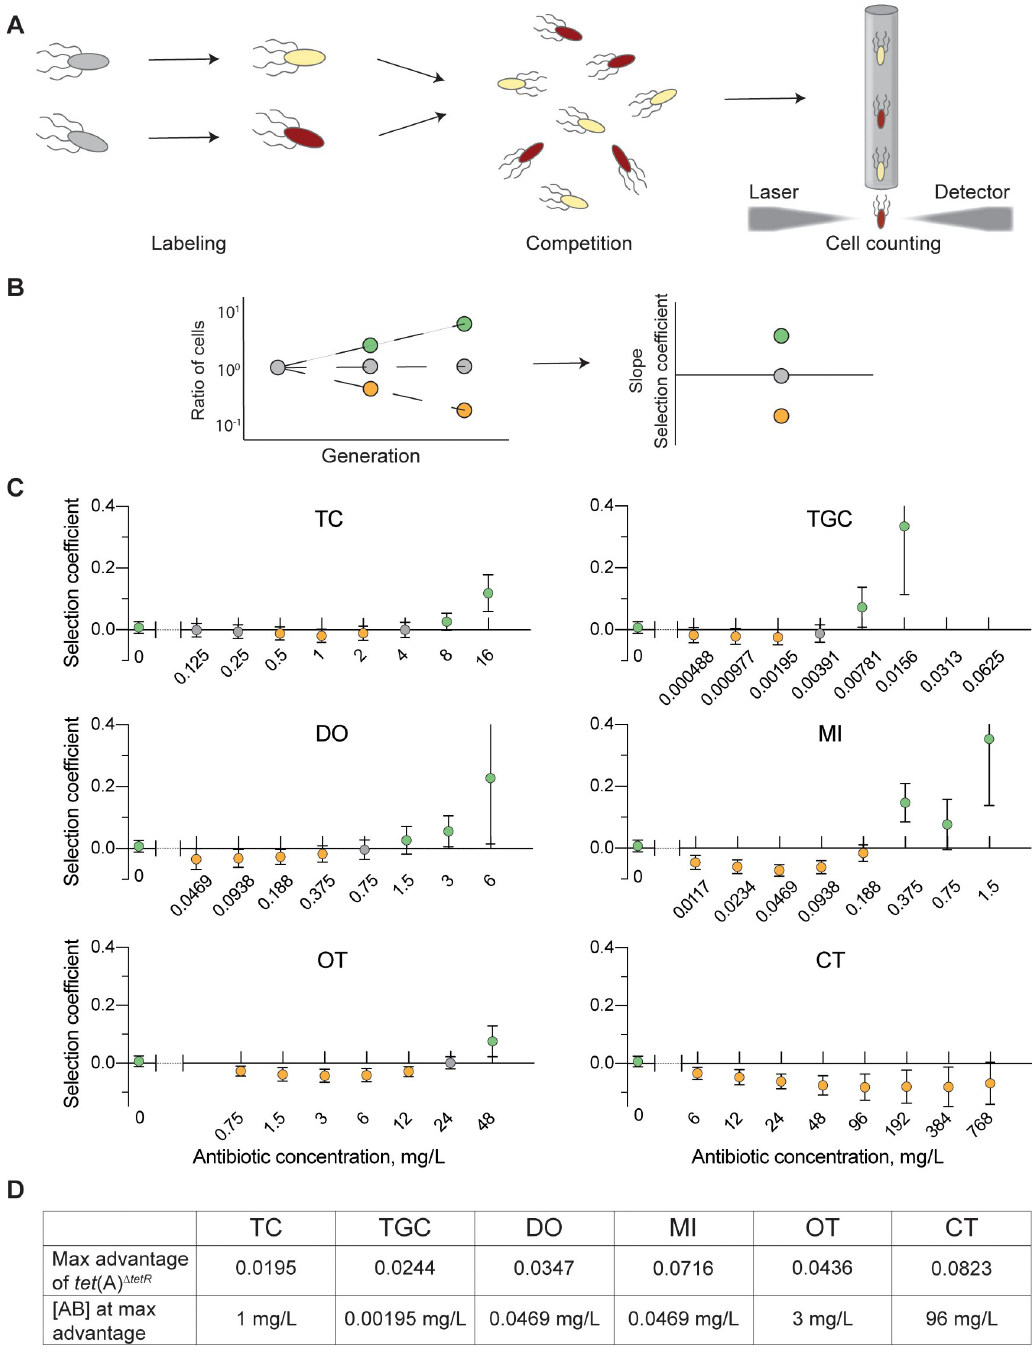
Fig 5. Competition analysis of strains carrying different tet (A) alleles in presence of increasing antibiotic concentrations. ( A ) Schematic of head-to-head competition experiments. Isolates to be competed are labelled with fluorescent markers and mixed at equal proportions. After competition growth, cells are counted using a flow cytometer to determine the cell ratio. ( B ) Example of ratios of cells measured over a period incubation (left). The slope of the change in ratio (allele X/allele Y) gives the selection coefficient, which is also plotted on the right. Green: positive selection coefficient (allele X has a fitness advantage over allele Y). Grey: neutral selection (neither allele has a fitness advantage). Orange: negative selection coefficient (allele Y has a fitness advantage over allele X). ( C ) Competitions of isogenic strains carrying either tet (A) wt or tet (A) Δ tetR , showing the selection coefficient ( tet (A) wt over tet (A) Δ tetR ) at different concentrations of TC, TGC, DO, MI, OT, and CT (Wilcoxon rank sum test). X-axis shows the antibiotic concentration in mg/L. The highest concentrations used correspond to 1/2 the MIC of the tet (A) wt